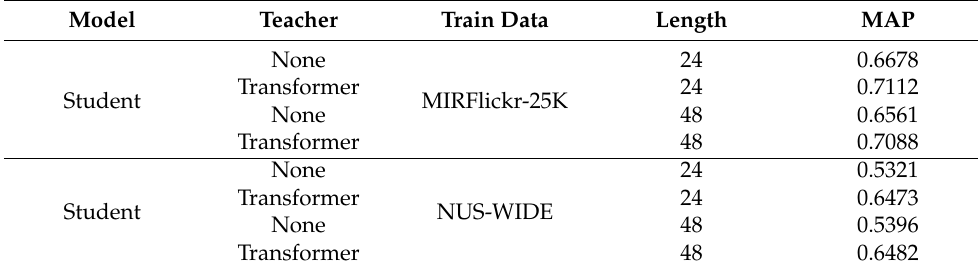
Table 2. Distillation experiment with the Transformer-based model as the teacher and the linear projection-based fast model as the student.